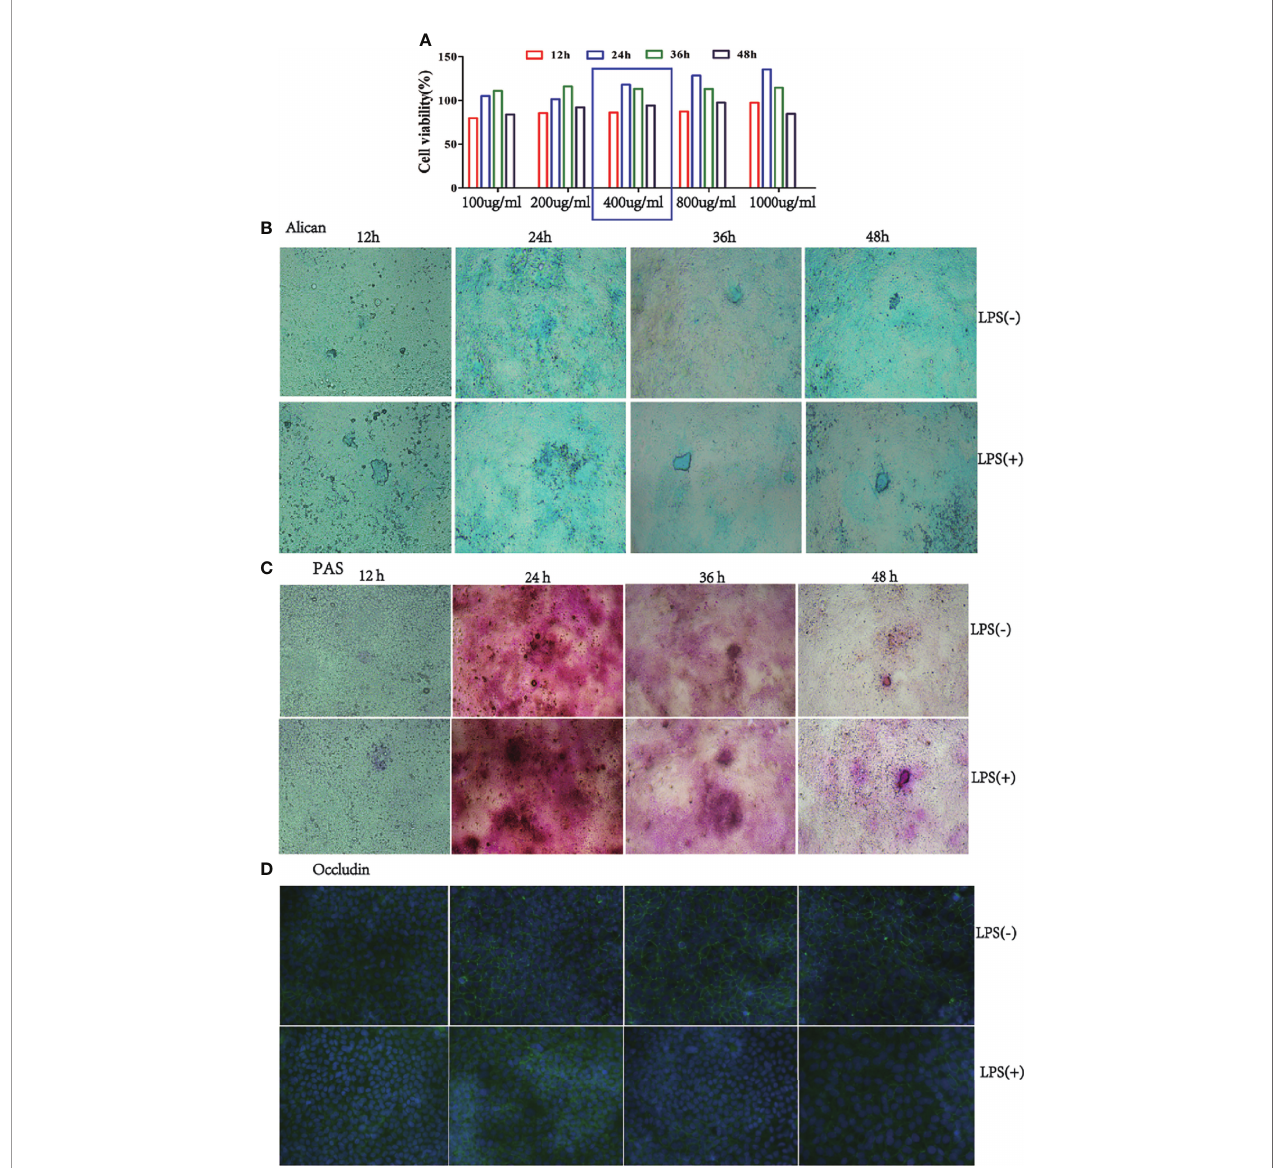
FIGURE 2 | Mucus expression in the co-culture model at a 3:1 ratio of Caco-2/HT-29 cells. (A) , Viability of the Caco-2/HT-29 co-culture cell (3:1) was determined using CCK-8 after stimulation with 100, 200, 400, 800, and 1000 µg/mL LPS for 12 h, 24 h, 36 h, and 48 h (N=6); (B) , Alcian Blue staining of Caco-2 and HT-29 co-culture cell stimulated with LPS for 12 h, 24 h, 36 h, and 48 h. Blue areas indicate mucus deposition (Nikon Plan 10× objective lens); (C) , Periodic Acid-Schiff staining (PAS) on Caco-2/HT-29 co-culture cell stimulated with LPS for 12 h, 24 h, 36 h, and 48 h. Fuchsia areas indicate mucus deposition (Nikon Plan 10× objective lens); (D) , Occludin expression of Caco-2/HT-29 co-culture cell was analyzed by immuno fl uorescence. The green color represents the occludin expression of Caco-2 and HT-29 co-culture cells; blue color indicates the nucleus of Caco-2/HT-29 co-culture cell differentially expressed genes were found between the LPS (-) vs siMUC2+LPS group and LPS (+) vs siMUC2 +LPS group ( Figure 4B ). The fi rst 20 signaling pathways were measured by KEGG enrichment analysis between the LPS (-) vs. siMUC2+LPS (+) group and LPS (+) vs. siMUC2+LPS group ( Figure 4C ). The cell extracellular matrix (ECM) receptor interaction and focal adhesion signaling pathways were used to further study the mechanism of mucus layer function.